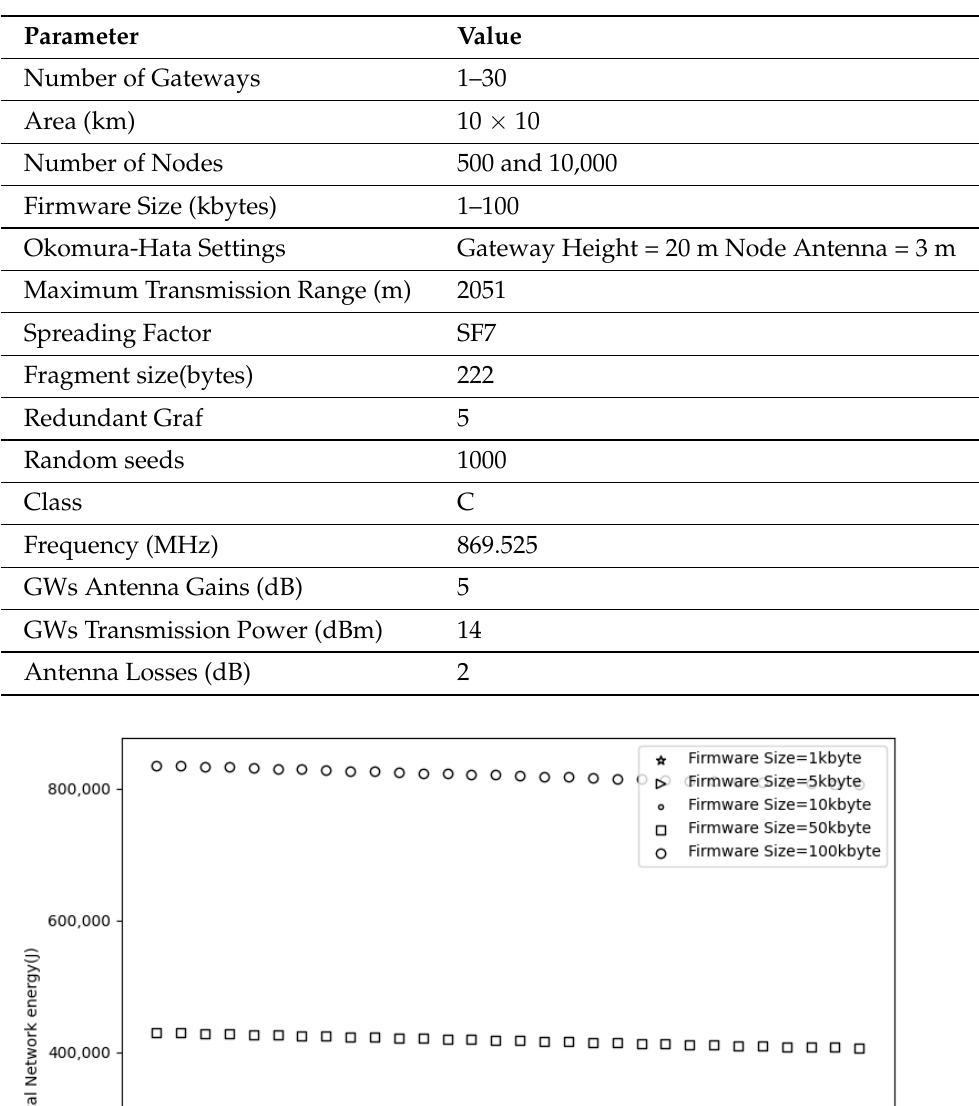
Table 1. Scenario parameters.